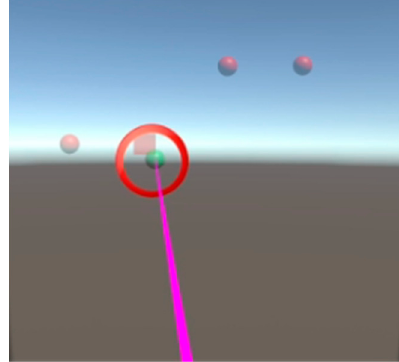
Figure 6. The ray/cursors(s) appearance when using the BTF’s and CONT as a guide for the selection. As for BTF-T, it appears only after the touch is made, and for BTF-R, it remains while the finger stays touched until released. The finger is not shown for clarity.